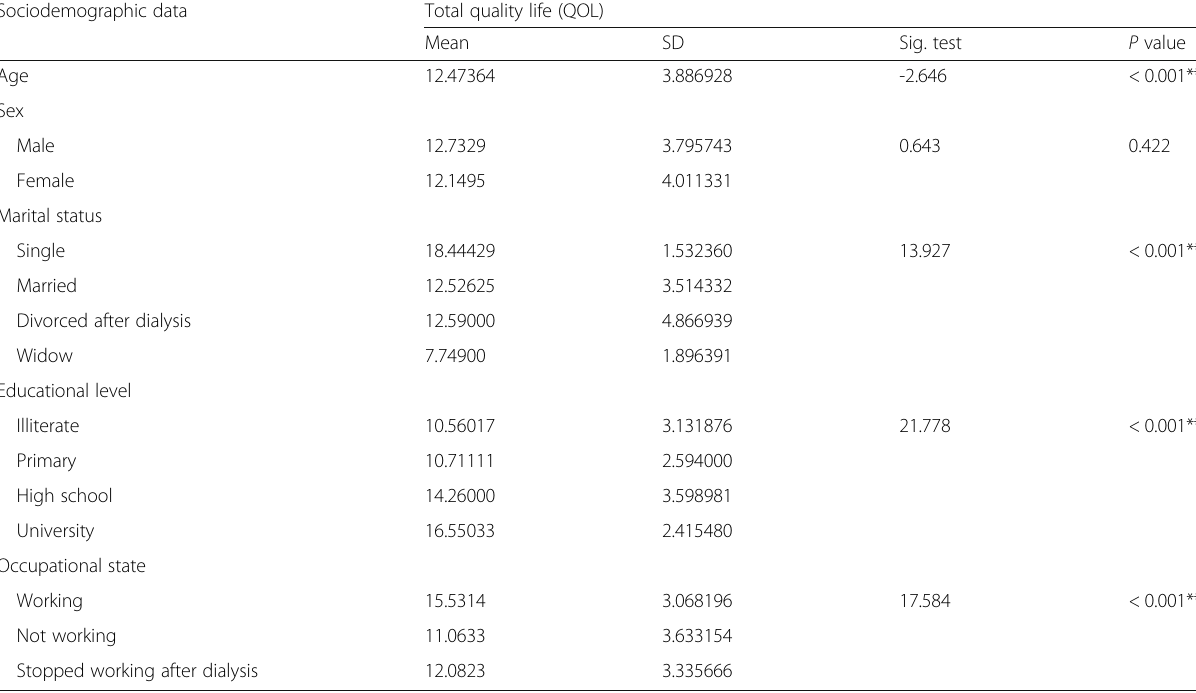
Table 3 Relation between sociodemographic data and QOL assessed by Ferrans and Powers Quality of life scale among ESRD patients Sociodemographic data